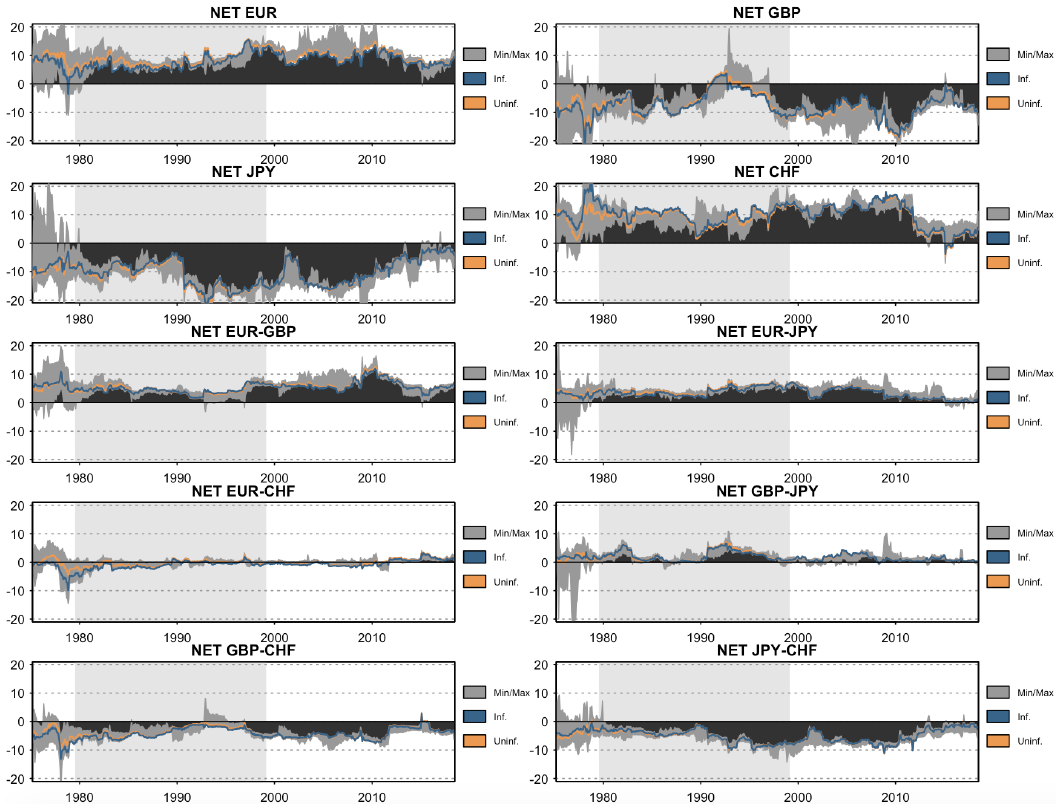
Figure 12. Net total and net pairwise directional connectedness measures of uncertainty.